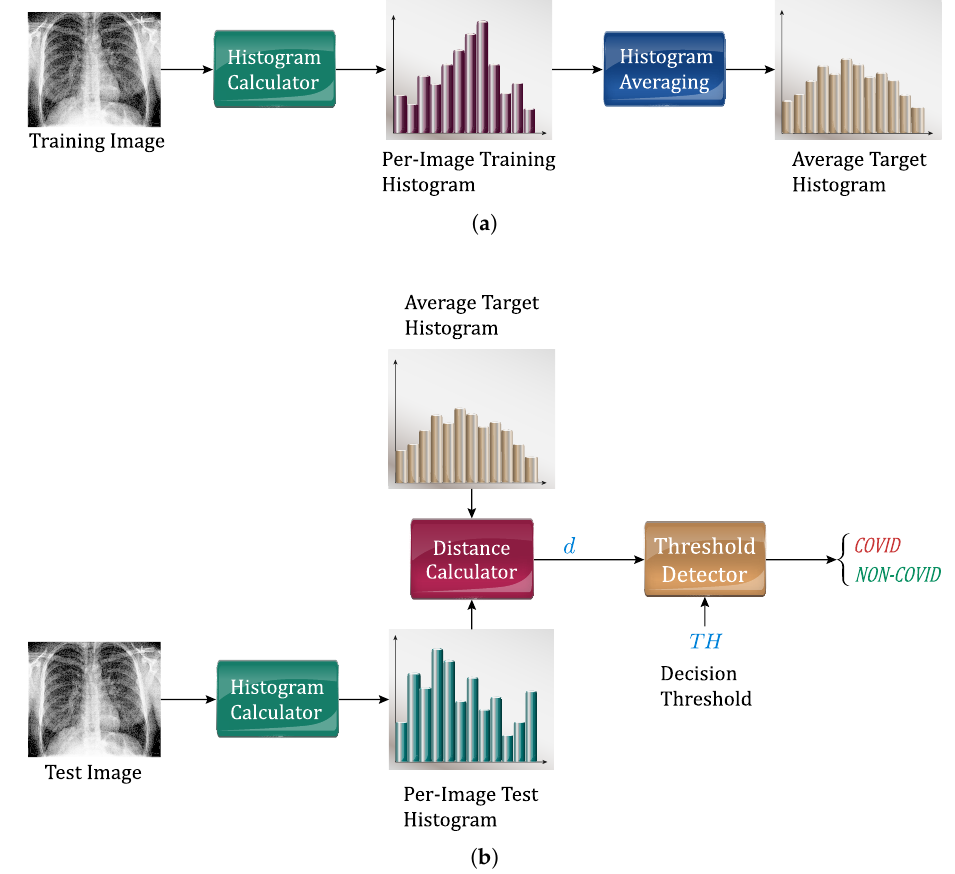
Figure 1. Proposed approach: ( a ) evaluation of the target histogram, and ( b ) inference phase for an unknown